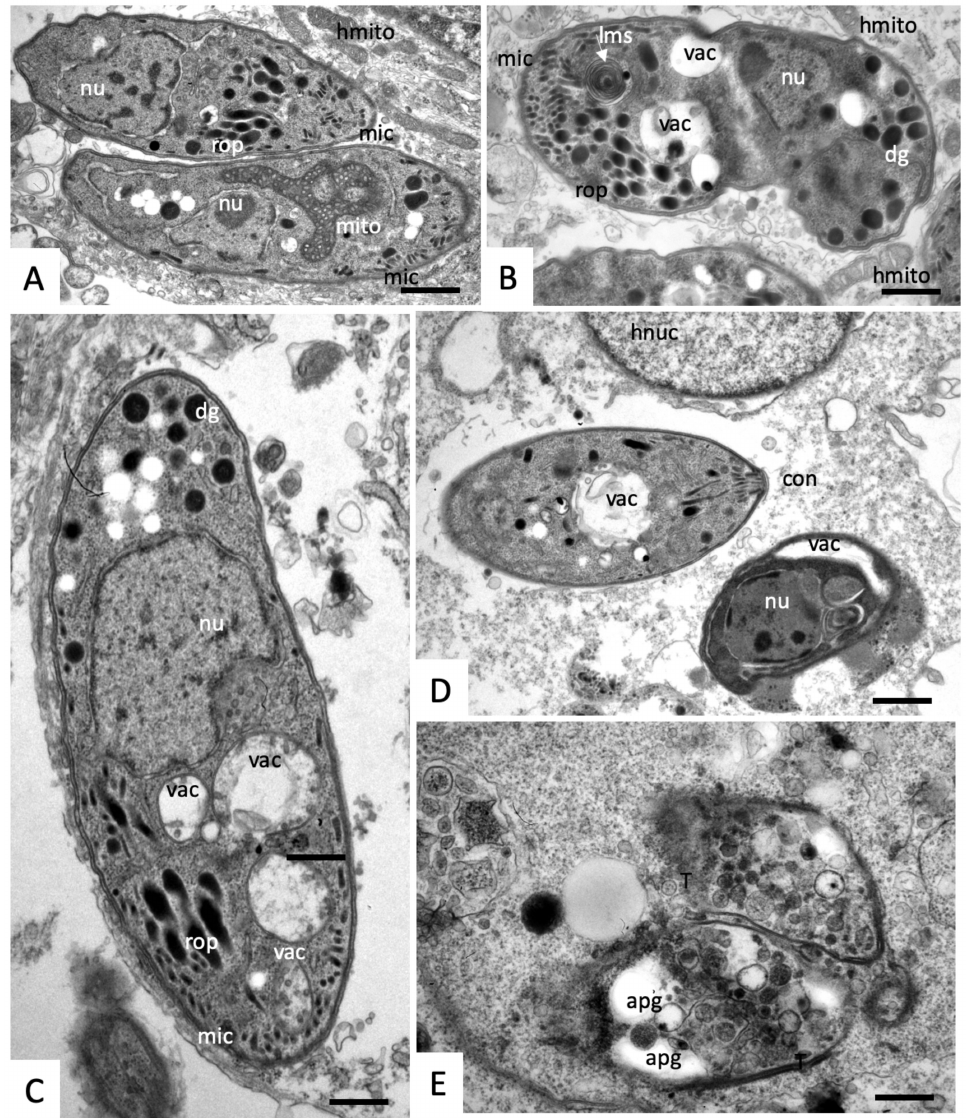
Figure 6. TEM of N. caninum tachyzoite-infected HFF treated with a 500-nM compound (2) and fixed and processed at di ff erent timepoints after the treatment began ( A , B ) = 6 h, ( C ) = 12 h, ( D ) = 24 h, ( E ) = 48 h). apg = amylopectin granules, con = conoid, dg = dense granules, ga = golgi apparatus, hmito = host cell mitochondrion, hnuc = host cell nucleus, mic = micronemes, mito = mitochondrion, nu = nucleus, pvm = parasitophorous vacuole membrane, pvn = parasitophorous vacuole network, rop = rhoptries, T = tachyzoites, vac = vacuolization. The bar in ( A , B ) = 0.6 µ m; ( C ) = 0.3 µ m; ( D ) = 0.5 µ m; ( E ) = 0.4 µ